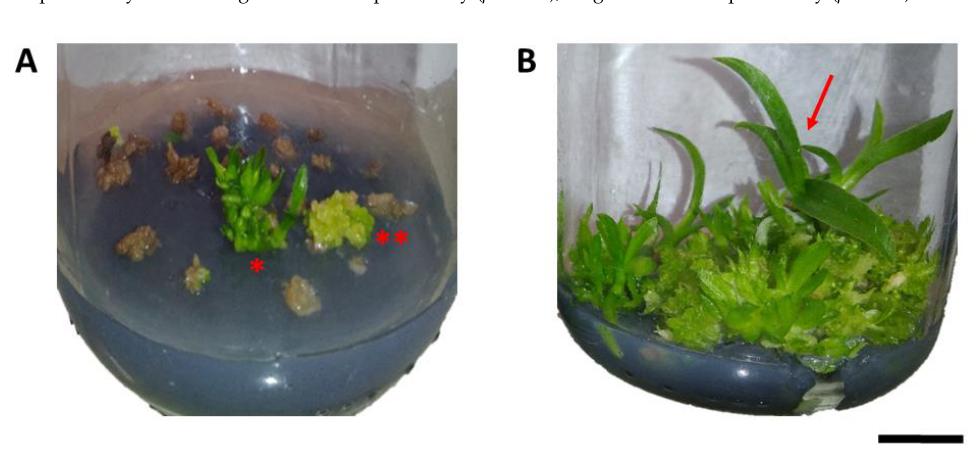
Figure 1. Effects of colchicine on in vitro protocorm survival of Blc . Haw Yuan Beauty × Blc . Goldenzelle “LC”: ( A ) protocorms cultured in MS medium for 120 days after treatment with colchicine at a concentration of 1000 µ M and exposure time of 24 h, showing dead tissues, regeneration of PLBs ** and plantlets *; ( B ) control treatment with protocorms in plant regeneration (red arrow). Scale bar = 1 cm.